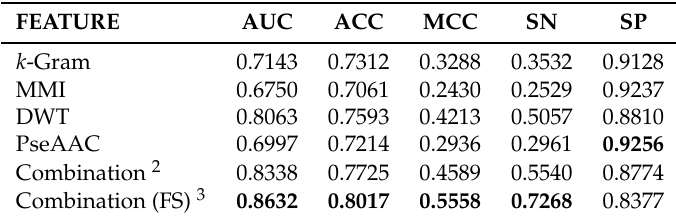
Table 2. The performance 1 of our method by using different features.